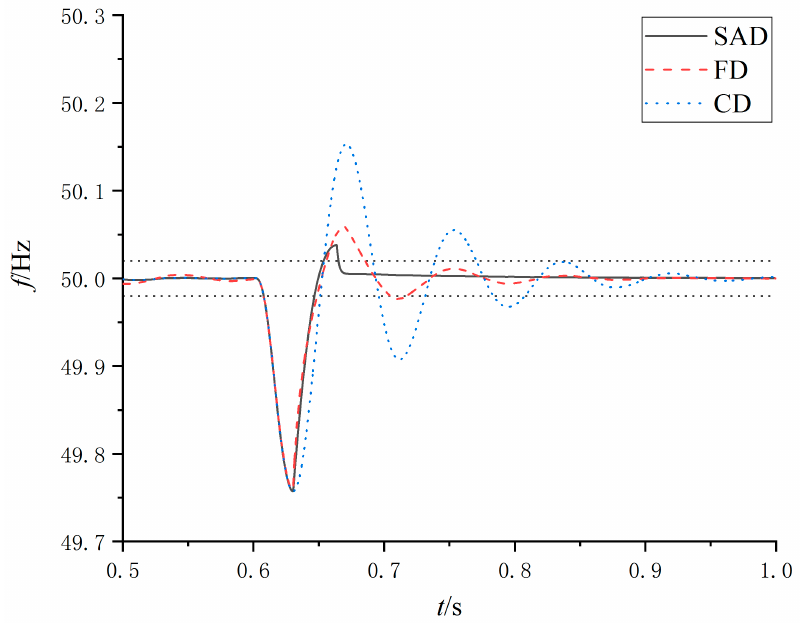
Figure 7. Comparison of frequency under di ff erent damping control strategies when load increases. Table 2. Comparison of di ff erent control strategies when load